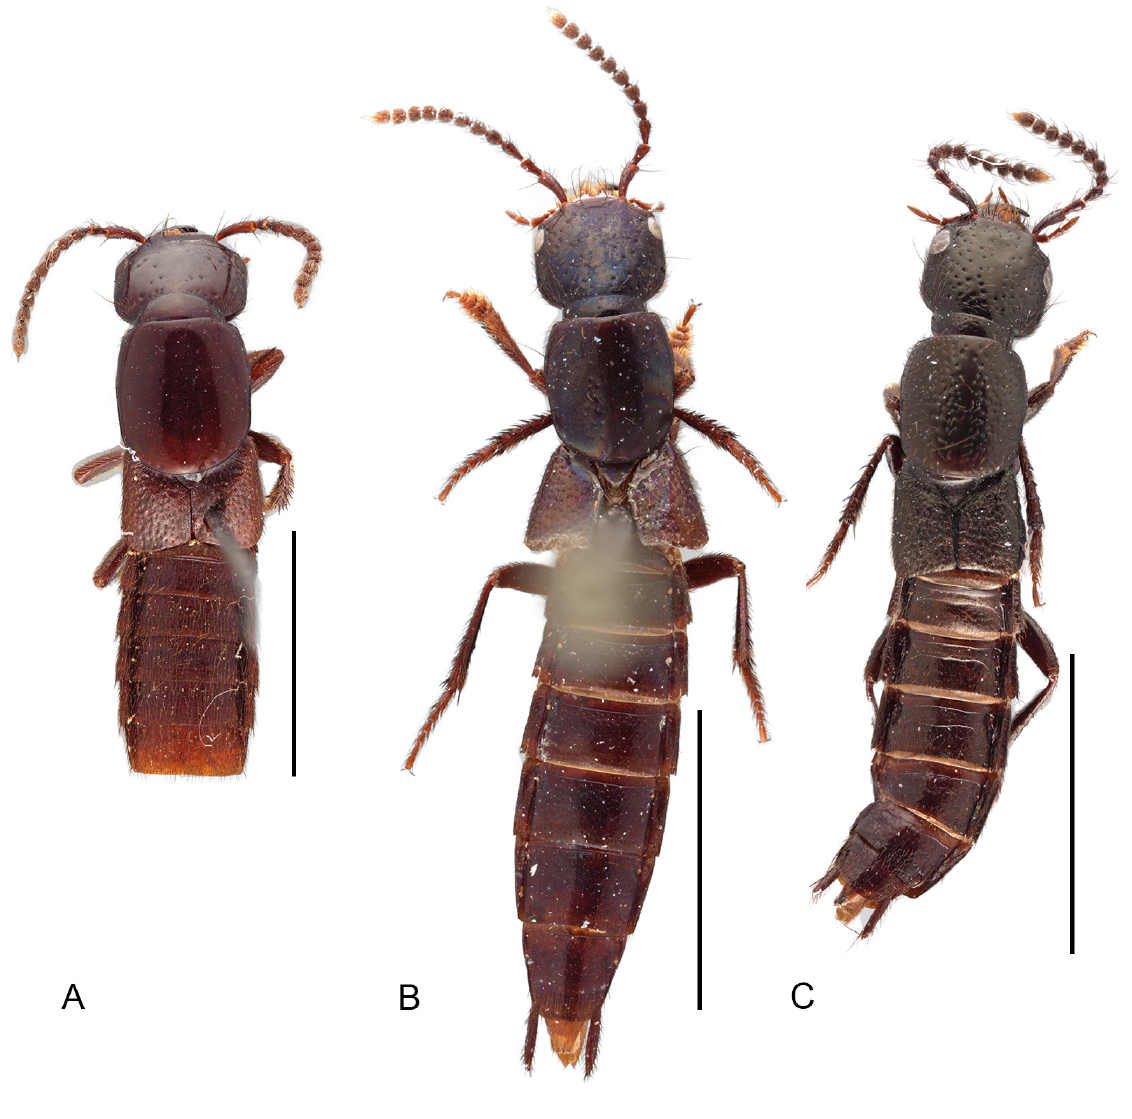
Fig. 2. Habitus photographs of species of Ikaros gen. nov. A . I. apteros gen. et sp. nov. Holotype, ♂ (SDEI). B . I. paramo gen. et sp. nov. Paratype, ♂ (barcode: SM05500251, UTCI). C . I. polygonos gen. et sp. nov. Holotype, ♂ (barcode: SM0114364, MIZA) . Scale bars = 5